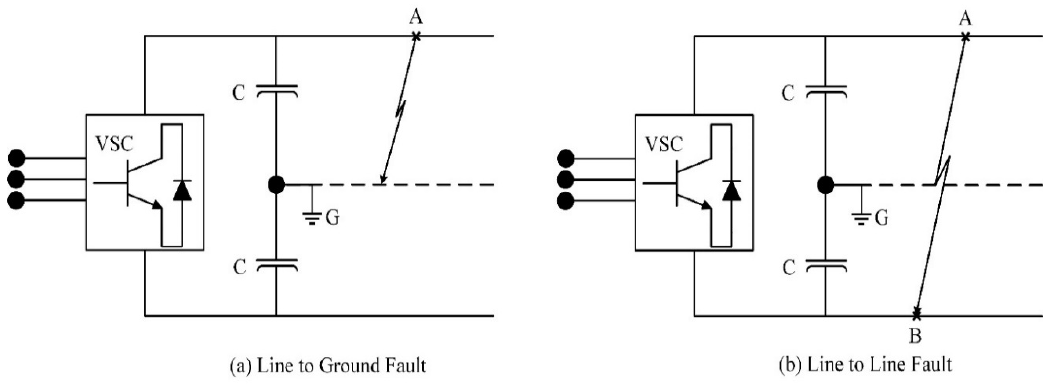
Figure 5. Types of faults in DC systems.